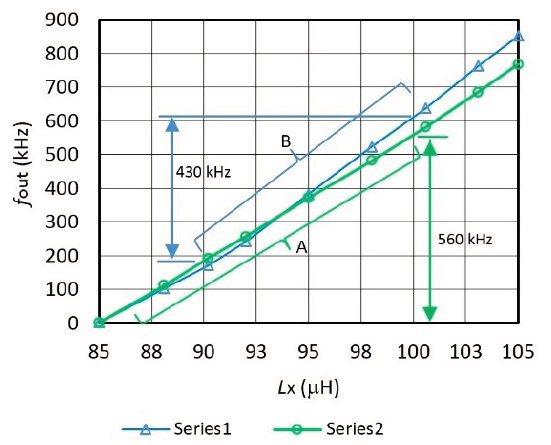
Figure 6. Compensated frequency characteristics for two different values of C 10 at L ref = 85